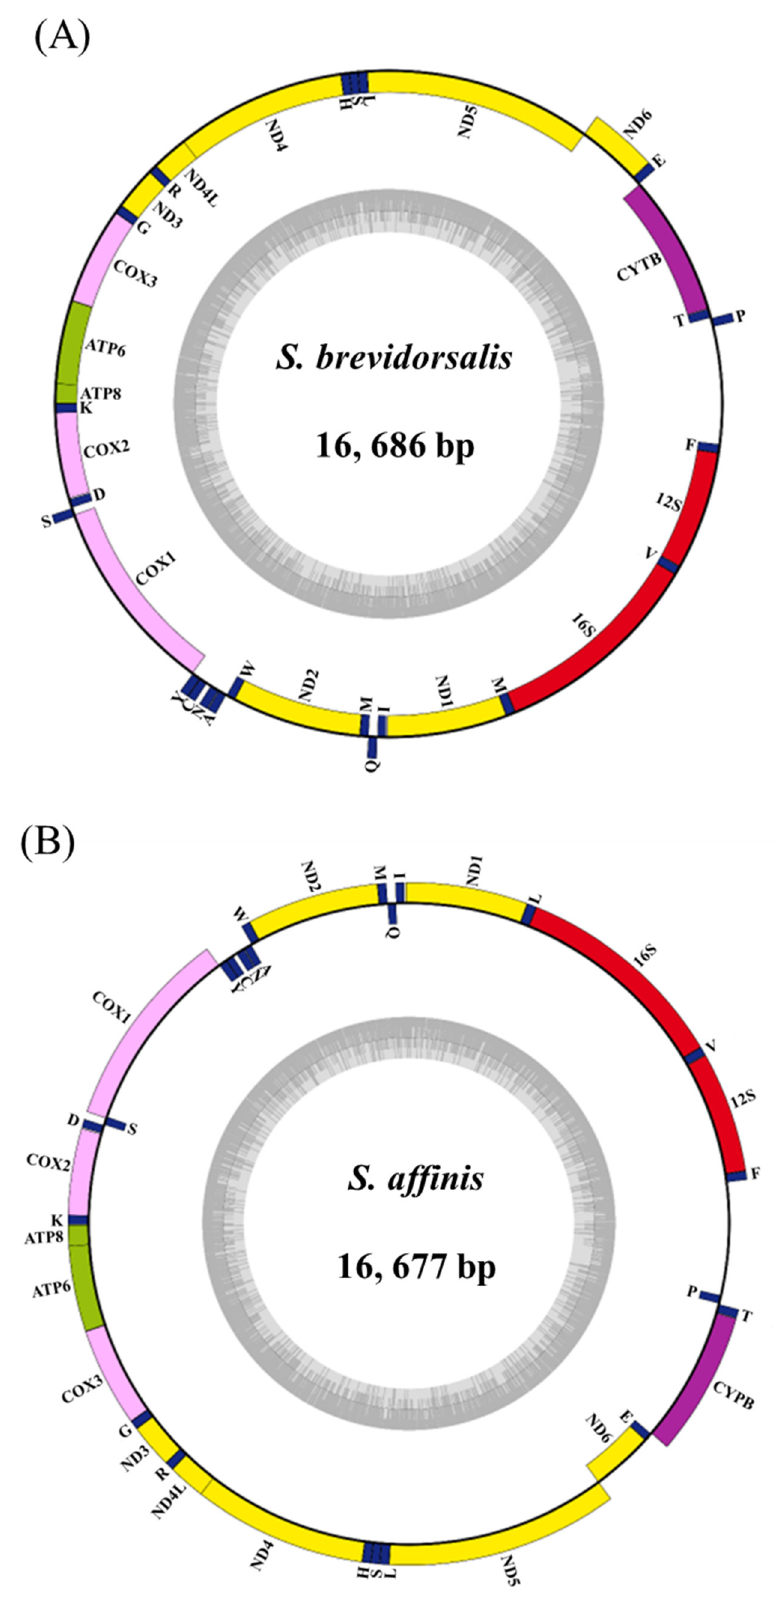
Figure 1. Organization of the mitochondrial genome of two deep-sea eel specimens. ( A ) S. brevidorsalis and ( B ) S. affinis . Genes encoded by the heavy (H) strand are shown outside the circle, and those encoded by the light (L) strand are shown inside the circle.